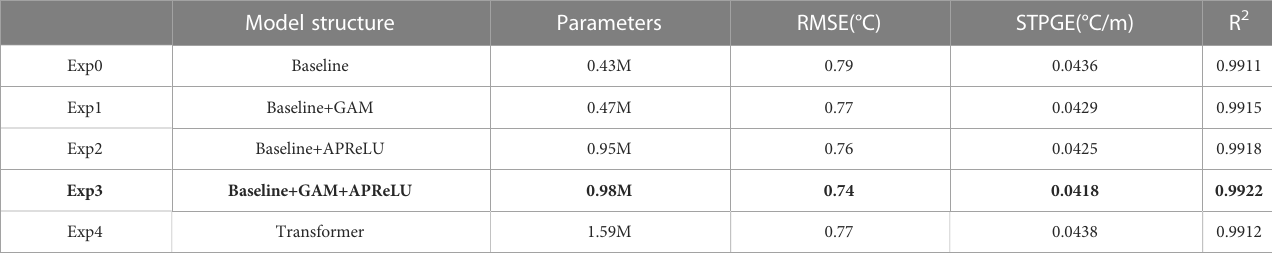
TABLE 2 Comparison of metrics on test set using different model